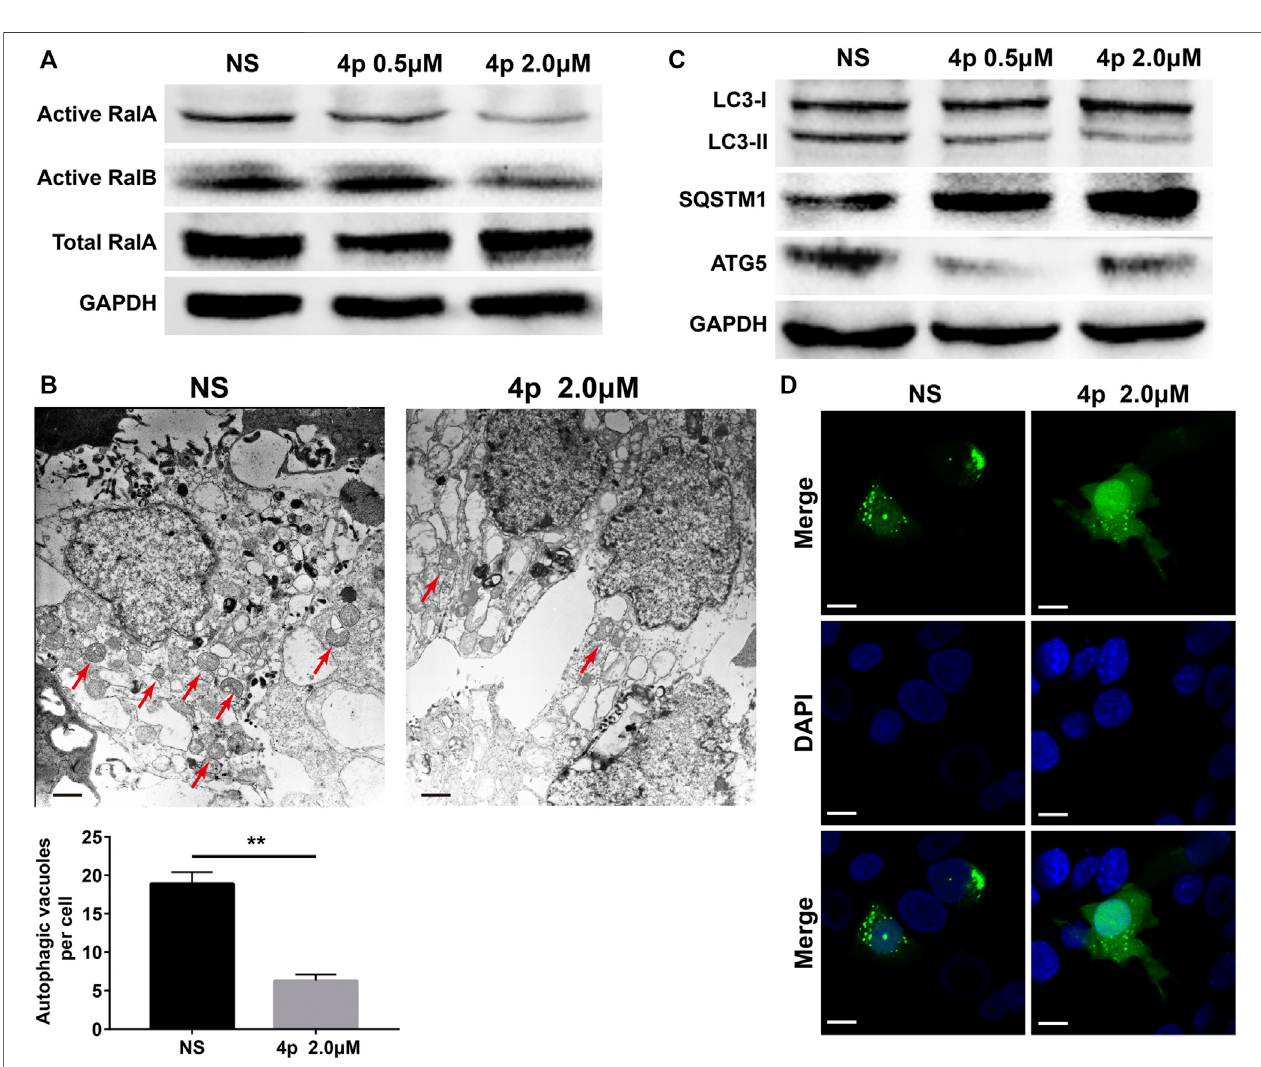
FIGURE 5 | (A) Selective inhibition of 4p on RalA was observed by the GST pulldown test; (B) Transmission electron micrograph of HepG2 cells treated with 4p , scale bar: 500 nm; (C) Western blotting was used to detect the change of the LC3-II/I ratio; (D) Formation of autophagosome in GFP-LC3 – transfected HepG2 cells induced by 2.0 μ M 4p , scale bar: 6 μ